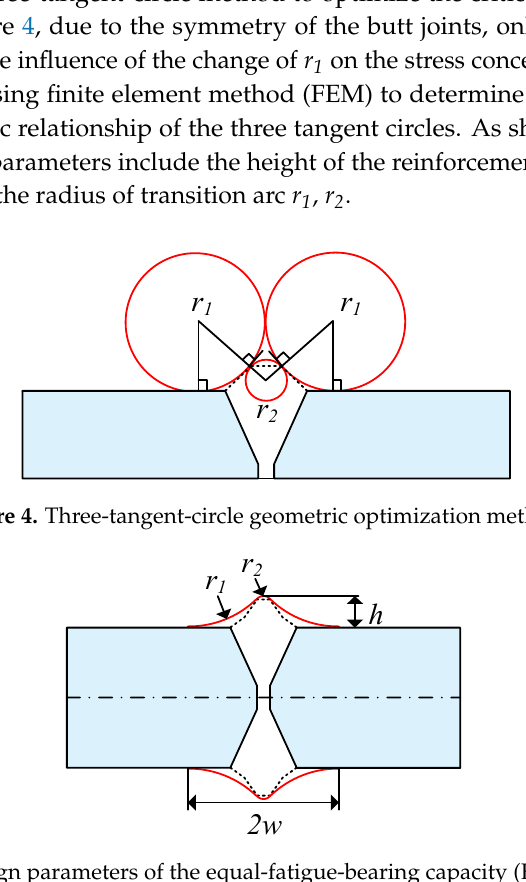
Figure 5. Design parameters of the equal-fatigue-bearing capacity (EFBC) method.